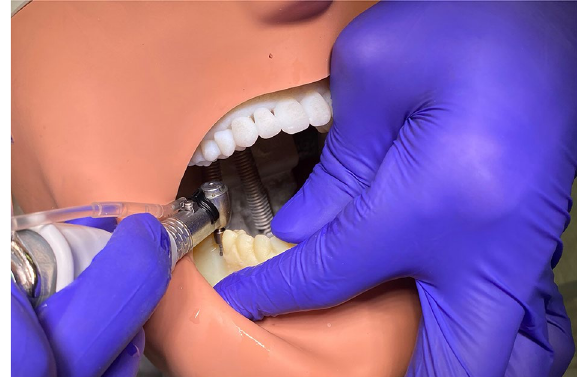
Figure 1. Freehand surgery.